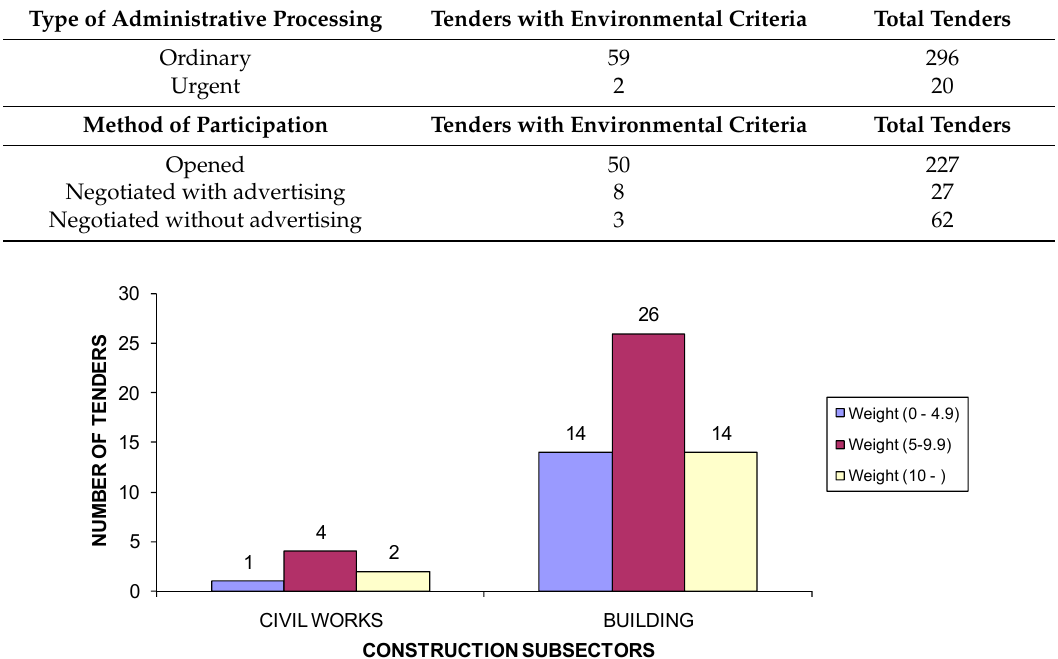
Figure 3. Number of tenders according to weighting of environmental criteria by construction subsector.